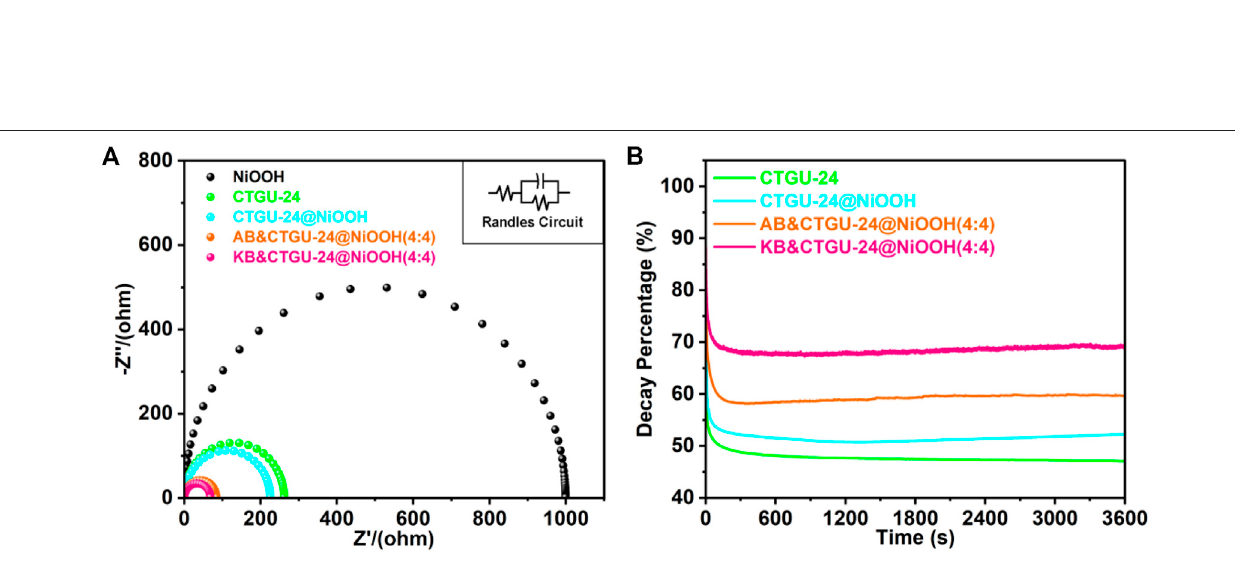
Frontiers in Chemistry |